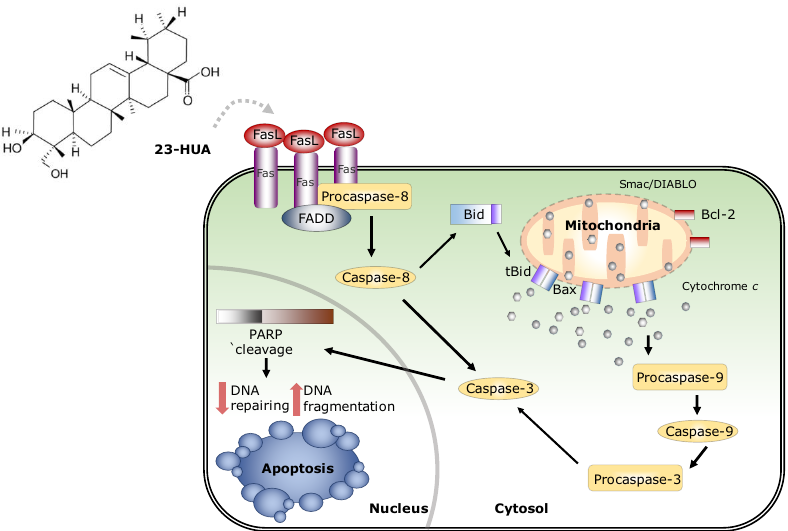
Figure 5. 23-hydroxyursolic acid-induced apoptosis via Fas/caspase-8-dependent pathway in HL-60 human promyelocytic leukemia cells.